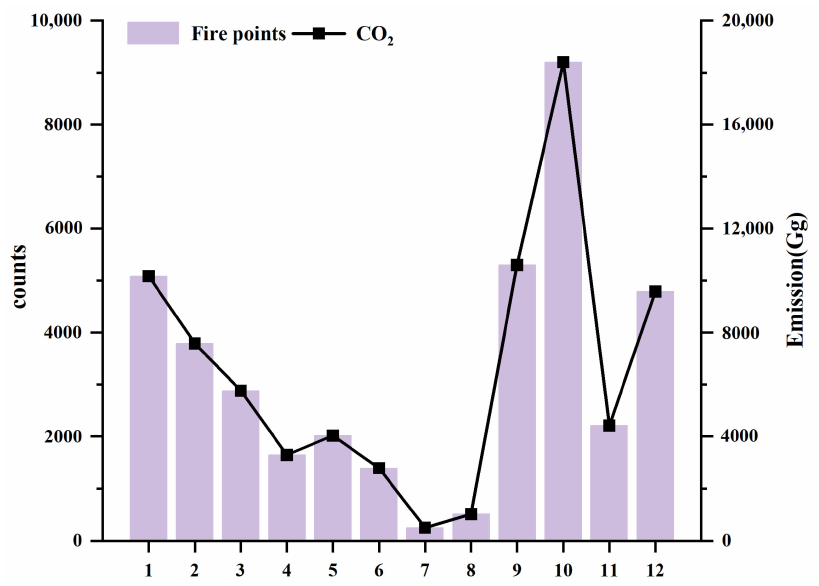
Figure 6. The monthly trend of the number of fire points and CO 2 emissions in Hubei from 2012 to